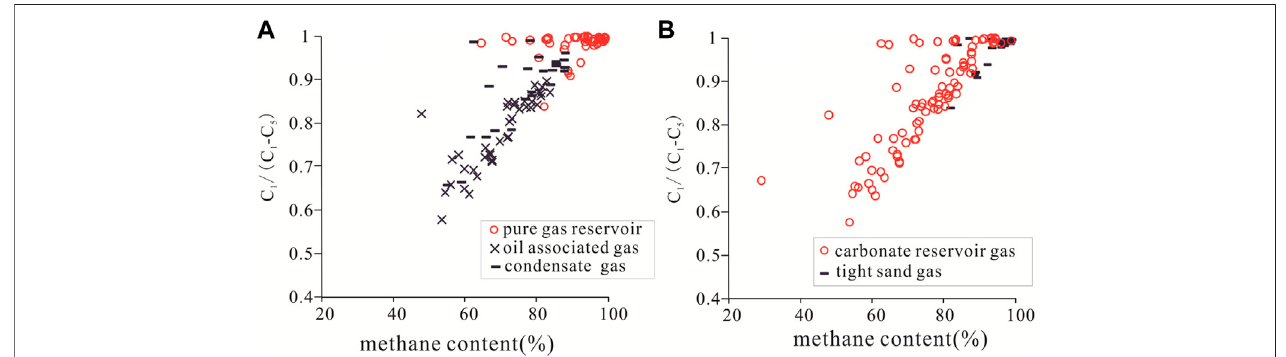
Frontiers in Earth Science |